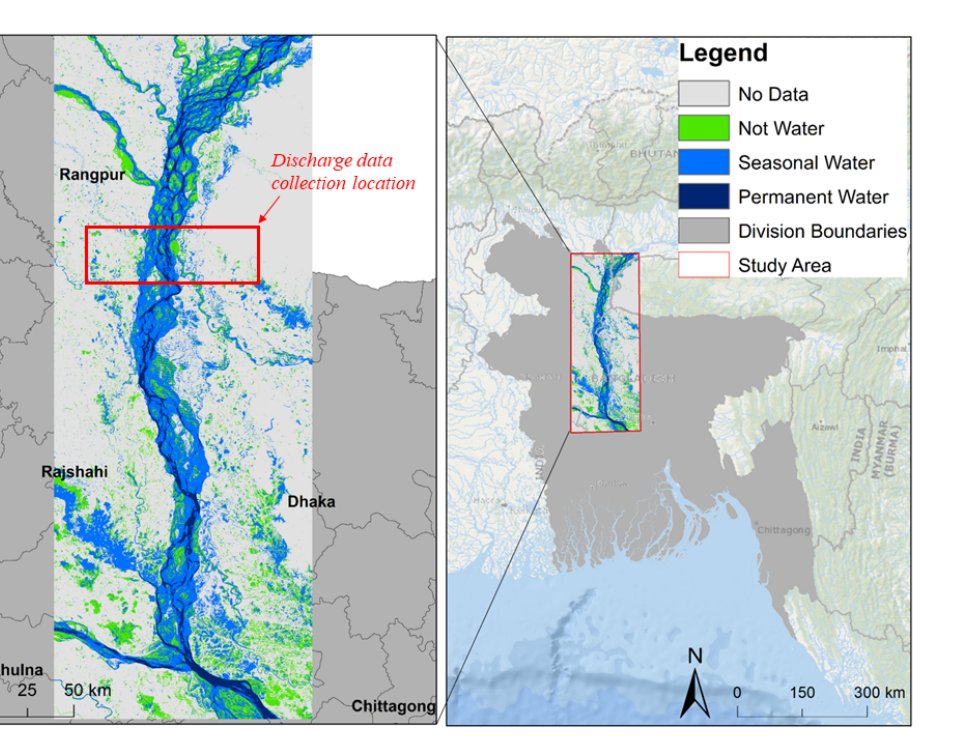
Figure 2. Brahmaputra River study region. The location of discharge data collection is depicted in